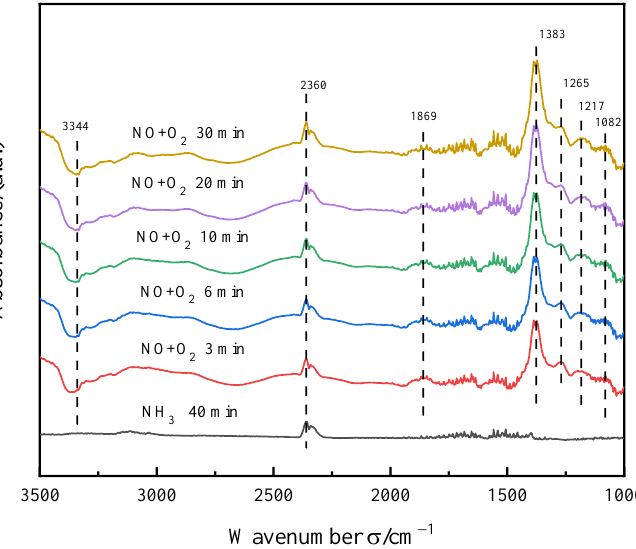
Figure 6. In situ DRIFTS of NO+O 2 reacting with pre-adsorbed NH 3 over the 4Cu-4Ce-4Zr/SAPO- 34 catalyst.